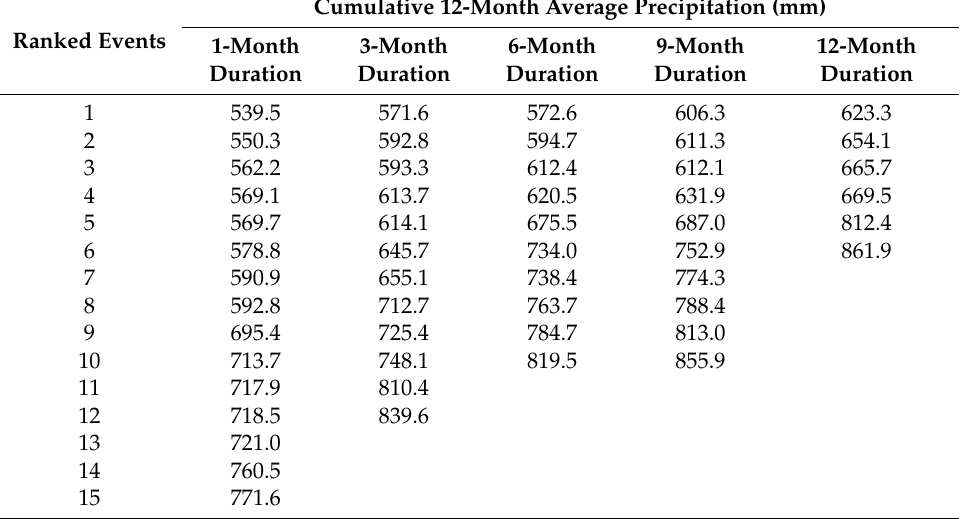
Table 3. Severity of events identified for S ã o Francisco